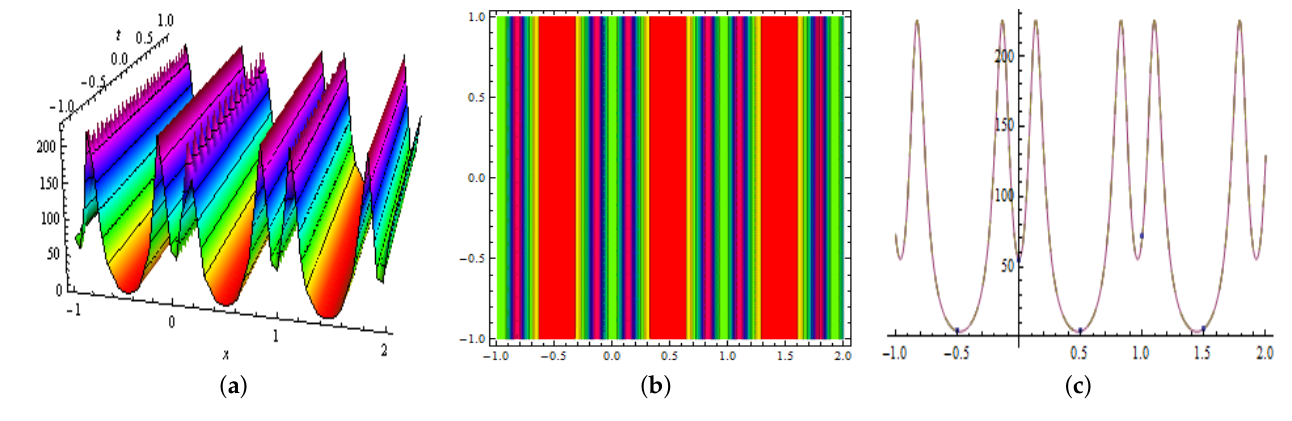
Figure 7. represented three-dimensions in ( a ); contour in ( b ) and two-dimensions in ( c ), Plots of n 38 ( x , t ) in Equation (34) for a = 0.5, b 6 = 1, b 7 = − 2, b 8 = 2, b 9 = − 6, α = 0.8, respectively. Set